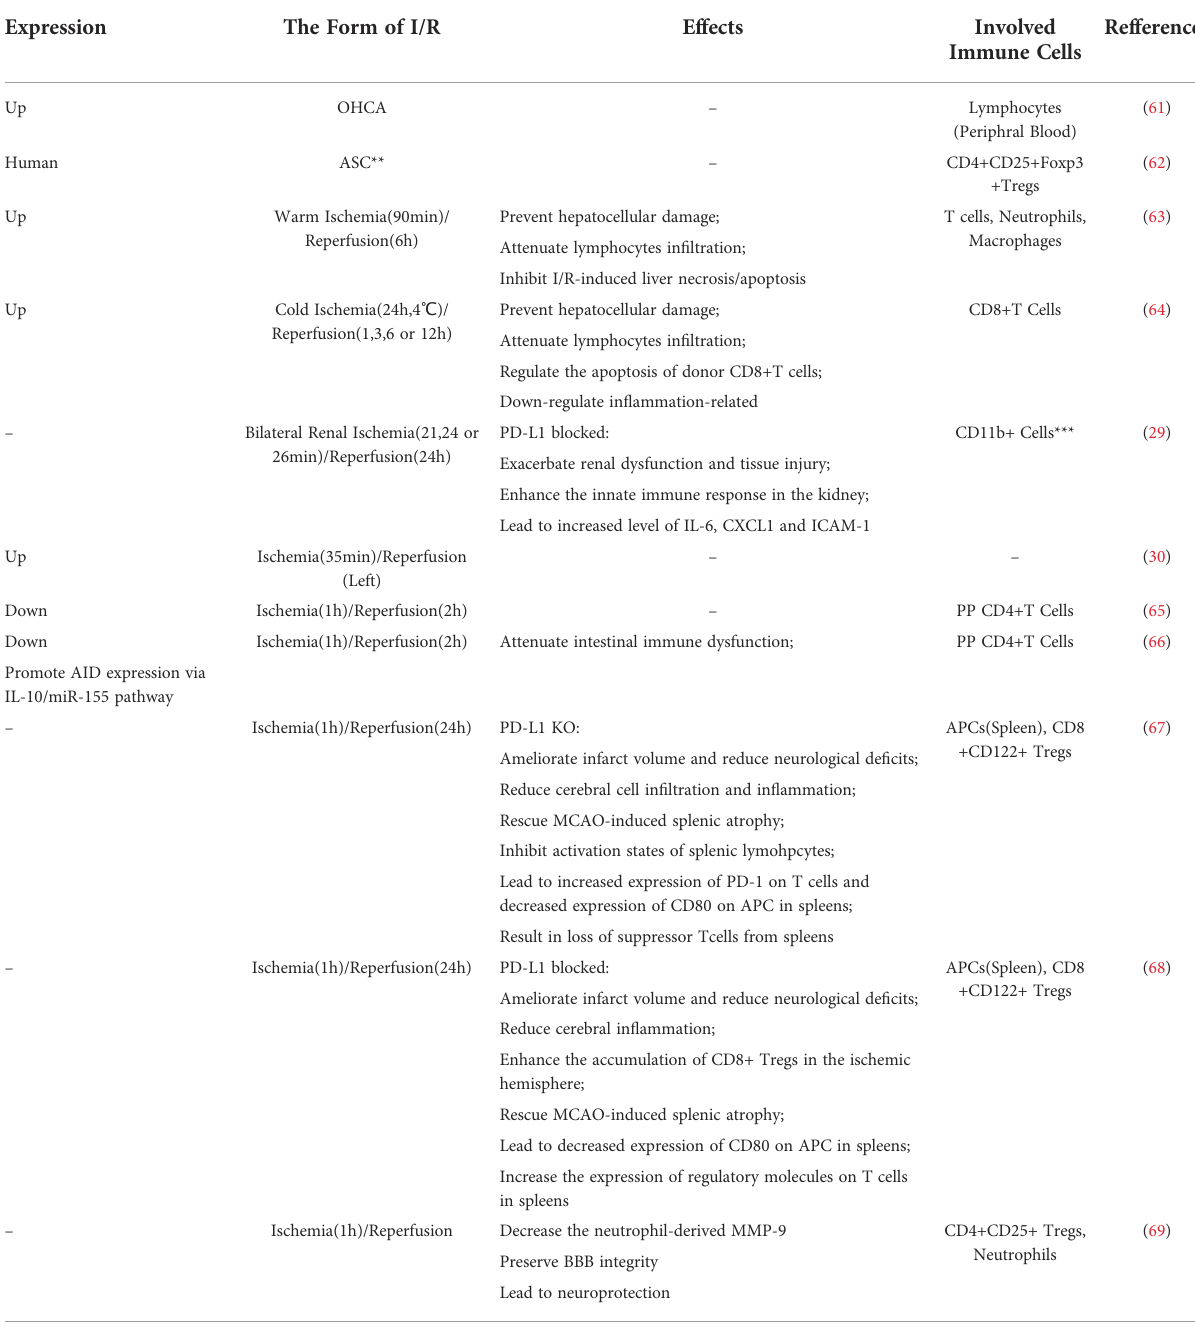
TABLE 1 PD-L1 in I/R